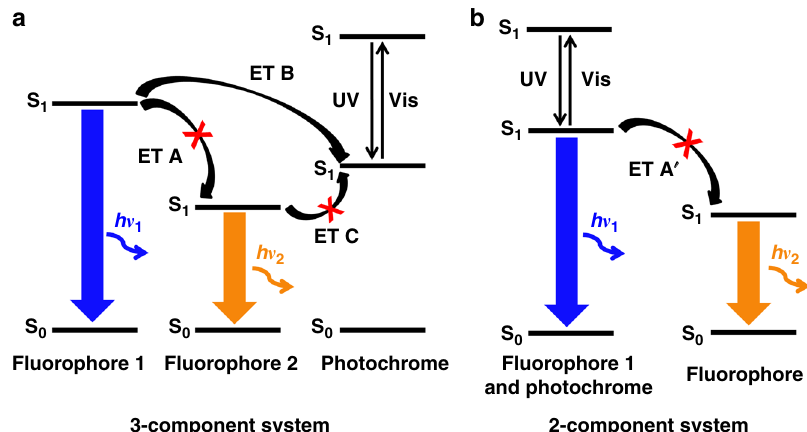
Fig. 1 Energy transfer schemes for color-speci fi c photoswitching. Schematic illustrations of the energy levels and the energy transfer (ET) processes upon UV and visible-light irradiation in color-speci fi c photoswitching systems: ( a ) three-component system and ( b ) two-component